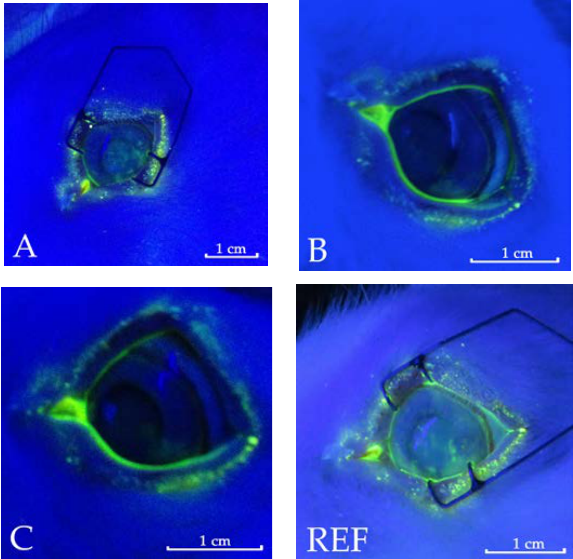
Figure 8. Representative corneal images for the eyes treated with Formulation ( A ), ( B ), ( C ), and ( REF ) at 4 days. For REF and ( A ) the images are taken for the fluo-positive eyes while for ( B ) and ( C ) the eyes are without coloured spot on the